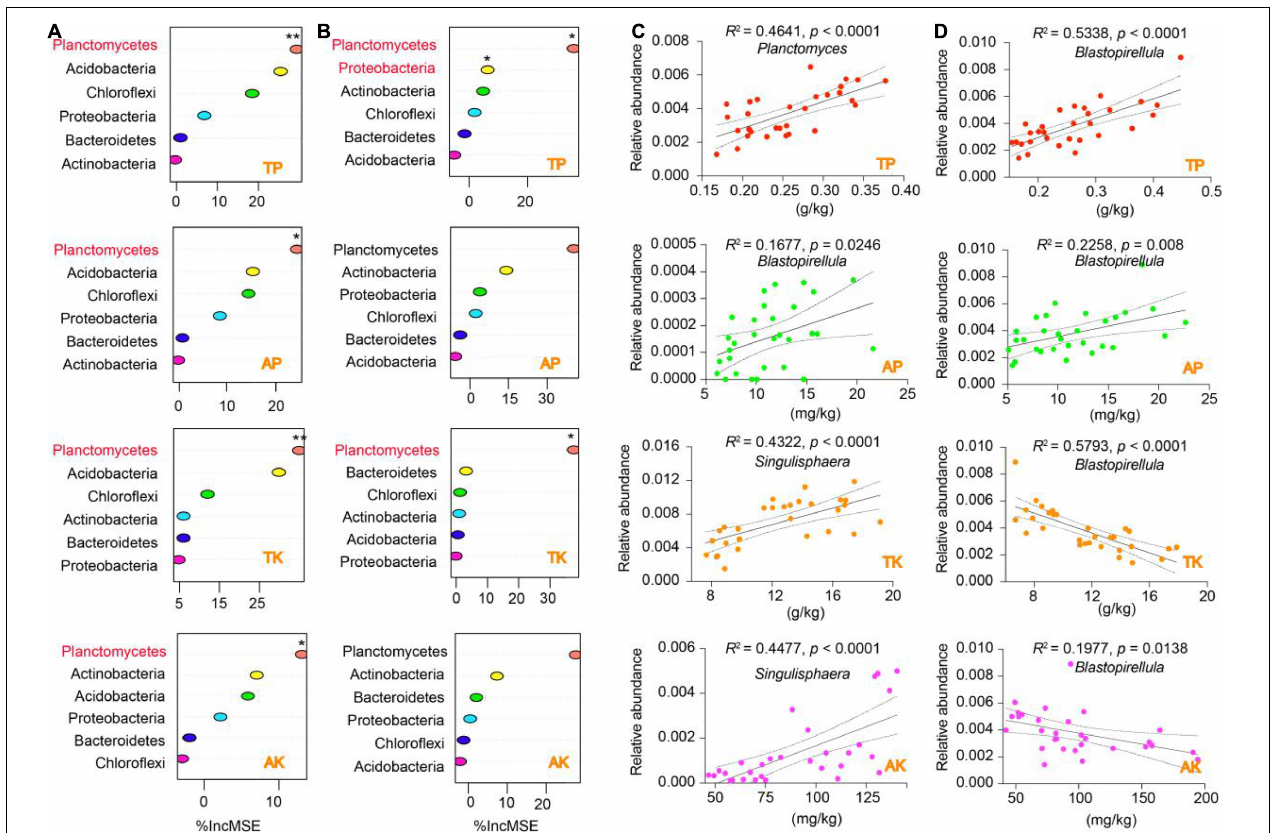
FIGURE 6 | Putative drivers of variation in soil nutrient cycling in the rhizosphere and bulk soil. (A,B) Percentage of increase of mean square error (IncMSE) of primary phyla was used to estimate the potential driver of four soil nutrient indicators (i.e., TP, AP, TK, and AK) for rhizosphere (A) and bulk soil (B) . The accuracy was counted for individual trees and averaged over the whole forest (2,000 trees). Significance levels are as follows: * p < 0.05, ** p < 0.01. (C,D) Linear regression analysis identified specific bacterial genera explained by soil nutrient indicators for rhizosphere (C) and bulk soil (D) . The adjusted R 2 and p were used to determine the significance of models that were fitted with expectations. The figure also showed the 95% confidence intervals of the best-fit line. Abbreviations: TP, total phosphorus; AP, available phosphorus; TK, total potassium; AK, available